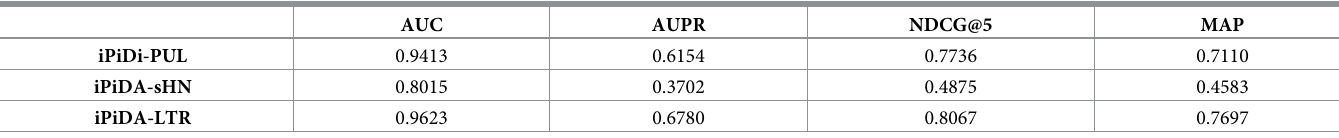
Table 5. The comparison results between iPiDA-LTR and two state-of-the-art S p